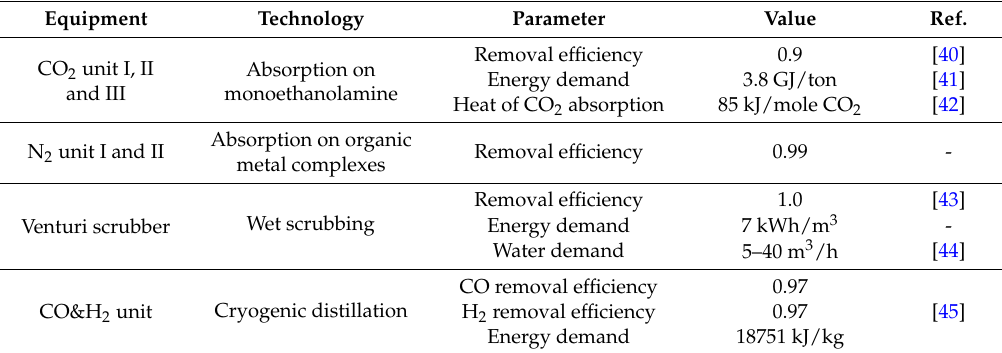
Figure 2. Schematic of the proposed SNG production unit. Table 1. Characteristics of the equipment in the SNG production unit.